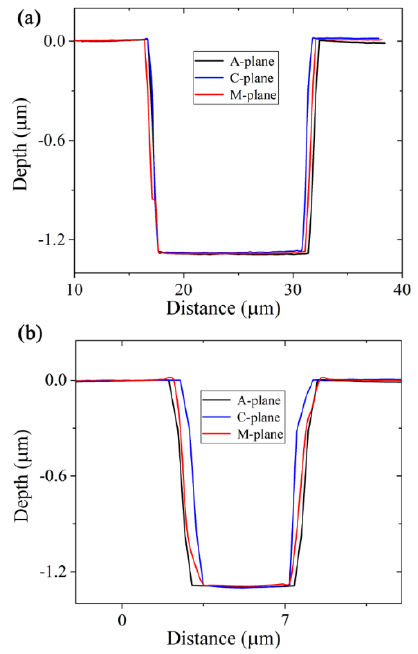
Figure 3. Cross-section depth profiles of etched pits along the horizontal direction ( a ) and vertical direction ( b ), respectively.